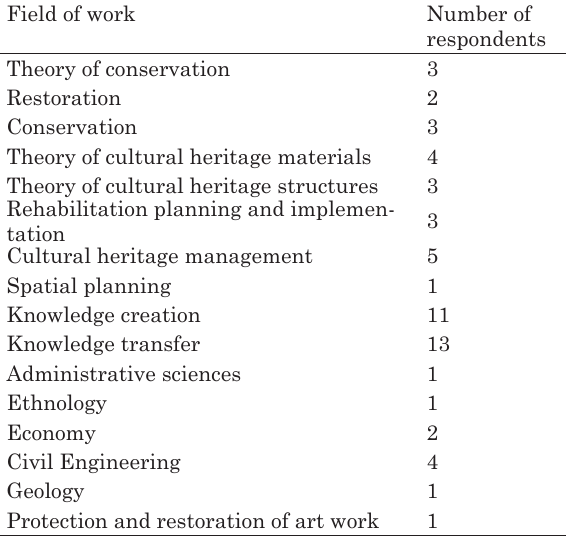
Table 3. Fields of work, covered by the sample of experts who participated in the AHP